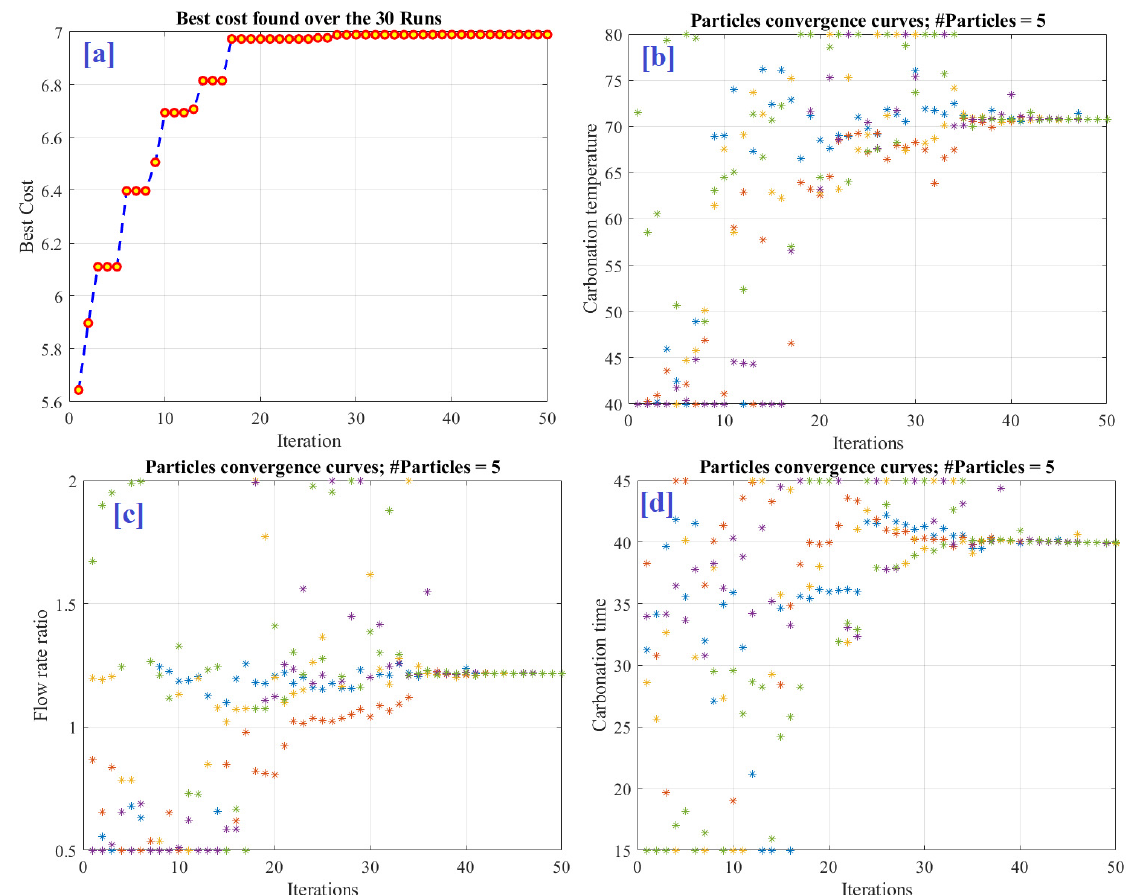
Figure 7. Optimization results ( a ) best objective function variation, ( b ) particle convergence of carbonation temperature, ( c ) particle convergence of carbonation time, and ( d ) particle convergence of H 2 O-to-CO 2 flow rate ratio.